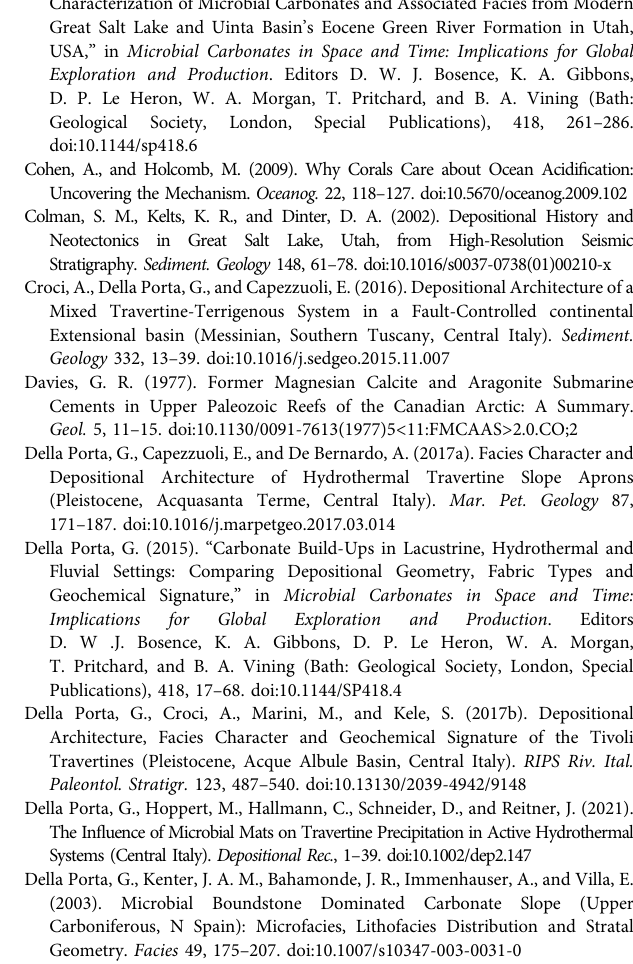
(B)Spheruliticaragonite(sametoFigureA)underSEM.(C)MineralogymapofFigure B, showing dominantly aragonite for both spherulitic aragonite and associated micriticnuclei.(D)CrystalfabricmapofFigureB,showinggradualtransitionbetween micritic nuclei (smaller crystal size, red color) to aragonite fi bers (larger crystal size, green or blue color). SUPPLEMENTARY FIGURE 2 | Thin section scans of samples containing botryoidal and spherulitic aragonite. (A) Firmground sample from Abu Dhabi microbial carbonates. (B) Sample of Great Salt Lake microbial bioherm showing the porous framework consisting ofclotted peloidal micrite and spherulitic aragonite fabric. (C) Bagni San Filippo travertine sample showing the laminated porous streamer fabric. SUPPLEMENTARYFIGURE3 |Microphotographs of botryoidal and spherulitic aragonite. (A) Botryoidal and spherulitic aragonite (indicated by red arrow) in the carbonate fi rmgrounds associated with microbial mats at Abu Dhabi. (B) Botryoidal and spherulitic aragonite (indicated by red arrows) in Abu Dhabi microbial carbonates. (C) Botryoidal and spherulitic aragonite (indicated by red arrow)associated with clotted peloidalmicriteformingthebulkframeworkofthe microbial bioherms at Great Salt Lake. (D) Image in crossed polarizers of botryoidal and spherulitic aragonite (indicated by red arrows) comprised within the clotted peloidal micrite forming the microbial bioherms at Great Salt Lake. (E) Botryoidal and spherulitic aragonite (indicated by red arrow) in travertine deposits at Bagni San Filippo. (F) Botryoids of fi brous aragonite (indicated by red arrows) nucleating on laminated clotted peloidal micrite framework in travertine deposits at Bagni San